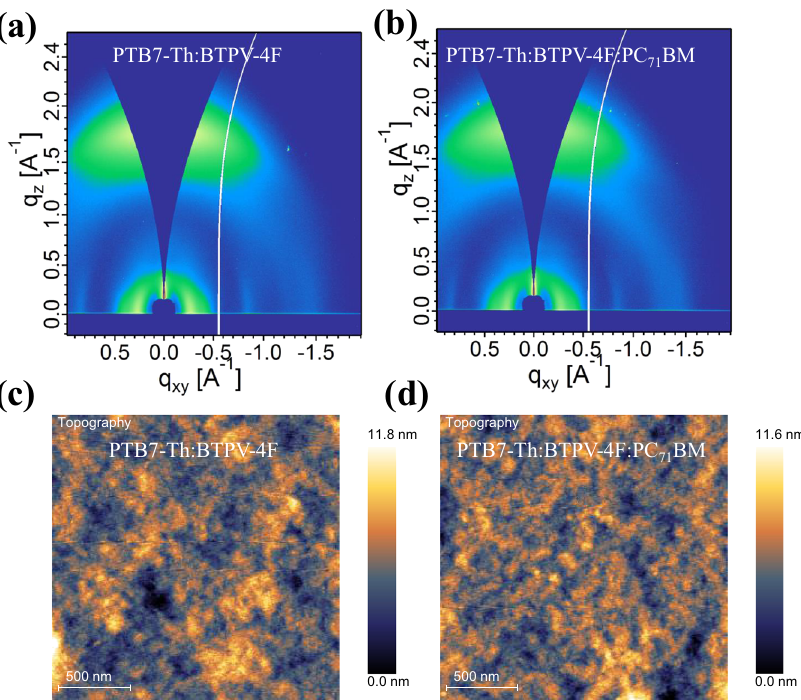
Fig. 5 GIWAXS and AFM analysis of PTB7-Th:BTPV-4F and PTB7-Th:BTPV-4F:PC 71 BM fi lms. 2D GIWAXS patterns of ( a ) binary blend fi lm of PTB7-Th: BTPV-4F and ( b ) ternary blend fi lm of PTB7-Th:BTPV-4F:PC 71 BM. AFM images of ( c ) PTB7-Th:BTPV-4F and ( d ) PTB7-Th:BTPV-4F:PC 71 BM fi